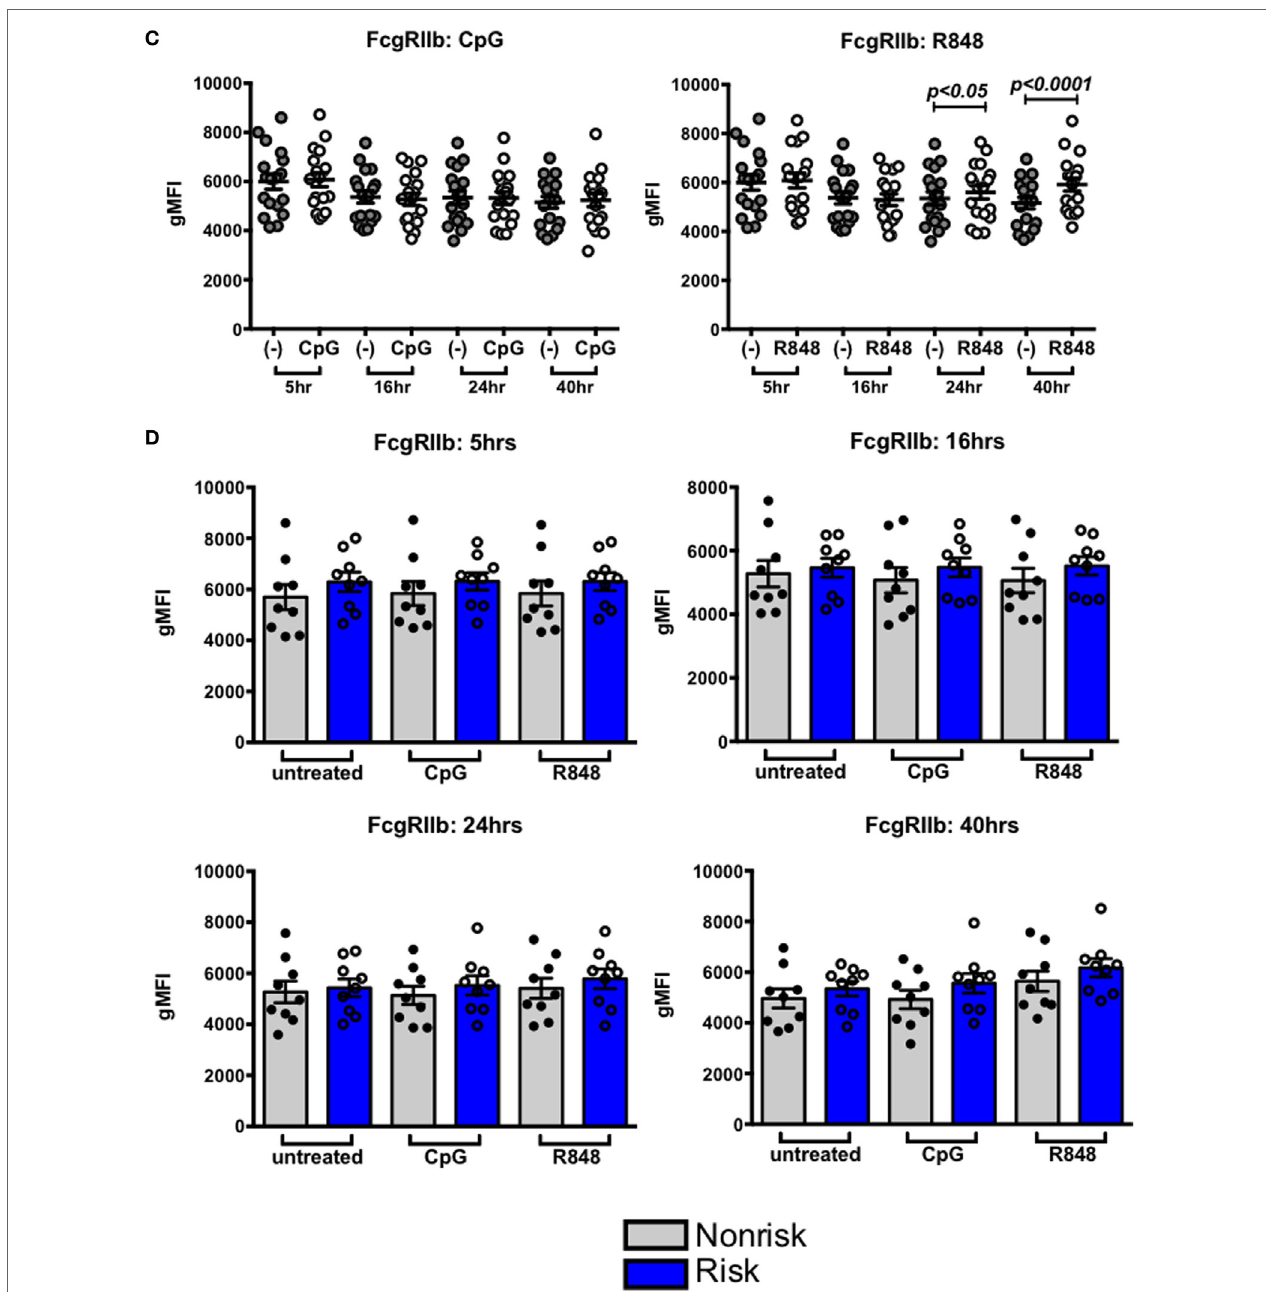
FigUre 8 | Interferon regulatory factor 5 activation does not affect Fc γ RIIb expression in B cells. (a,B) Fc γ RIIb mRNA expression in B cells treated with CpG (right) or R848 (left) for the indicated times. Results are combined (a) and separated by haplotype (B) . (c,D) Fc γ RIIb protein expression in B cells treated with CpG (right) or R848 (left) for the indicated time. Results are combined (c) and separated by haplotype (D) . All unstimulated cell expression values are normalized to 1.0. p < 0.05, p < 0.01, p < 0.001, and p < 0.0001 by Friedman test with Dunn’s multiple comparisons test (a,c) , p = ns by Mann–Whitney test for each treatment (B,D)